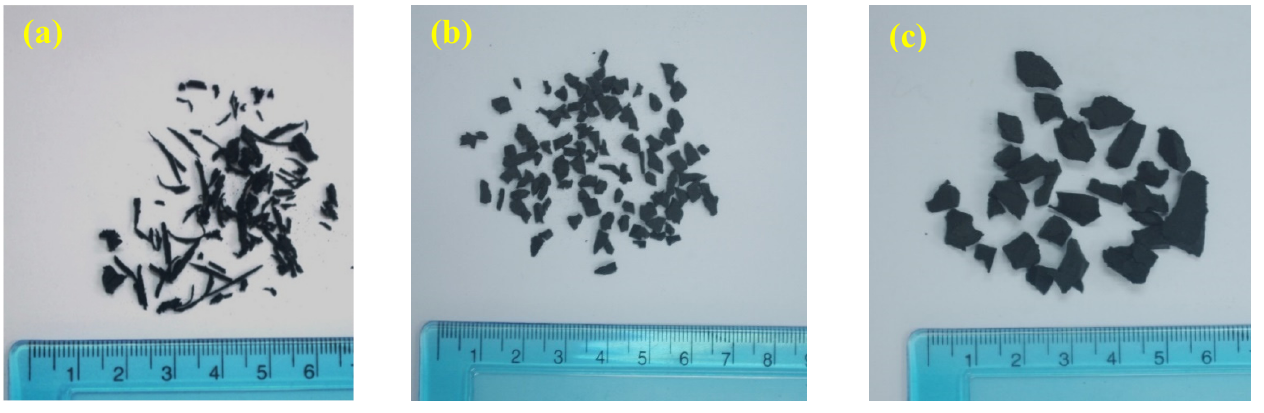
Figure 2. ( a ) Fine fibre rubber aggregate—Type R 1 , ( b ) Fine granular rubber aggregate—Type R 2 , ( c ) Coarse granular rubber aggregate—Type R 3 .